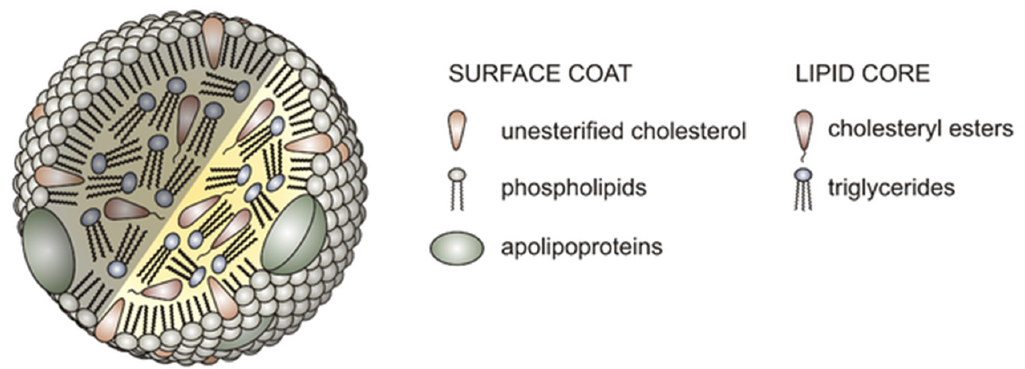
Figure 3. Structure of a lipoprotein. Lipoproteins are biochemical structures that function in the transport of water-insoluble lipids in the bloodstream. They consist of a hydrophilic outer shell (sur- face coat) composed of apolipoproteins, phospholipids, and unesterified cholesterol, and a lipid core consisting of cholesteryl esters and triglycerides. (Image adapted with permission from: Anti- Sense, CC BY-SA 3.0, https://creativecommons.org/licenses/by-sa/3.0, Accessed on 15 May 2022, via Wikimedia Commons).